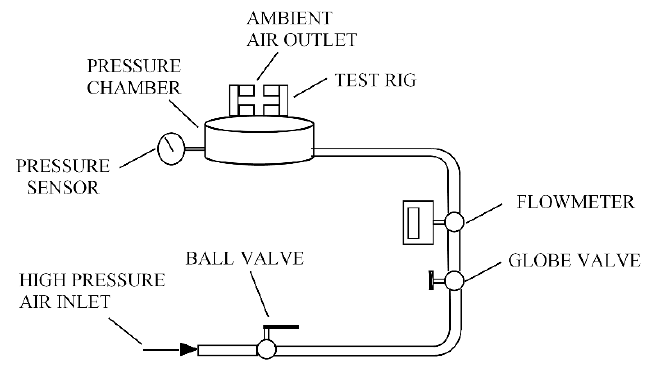
Figure 5. Schematic and connections of the test system.